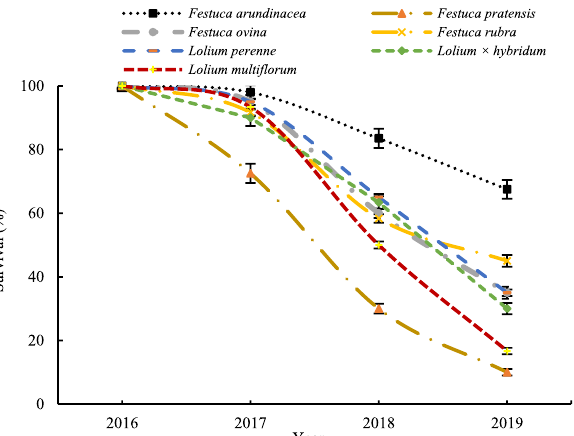
Figure 3. Trends of survival in seven grass species subjected to normal irrigation condition over years (2016– 2019). Error bar in each point is standard error in every